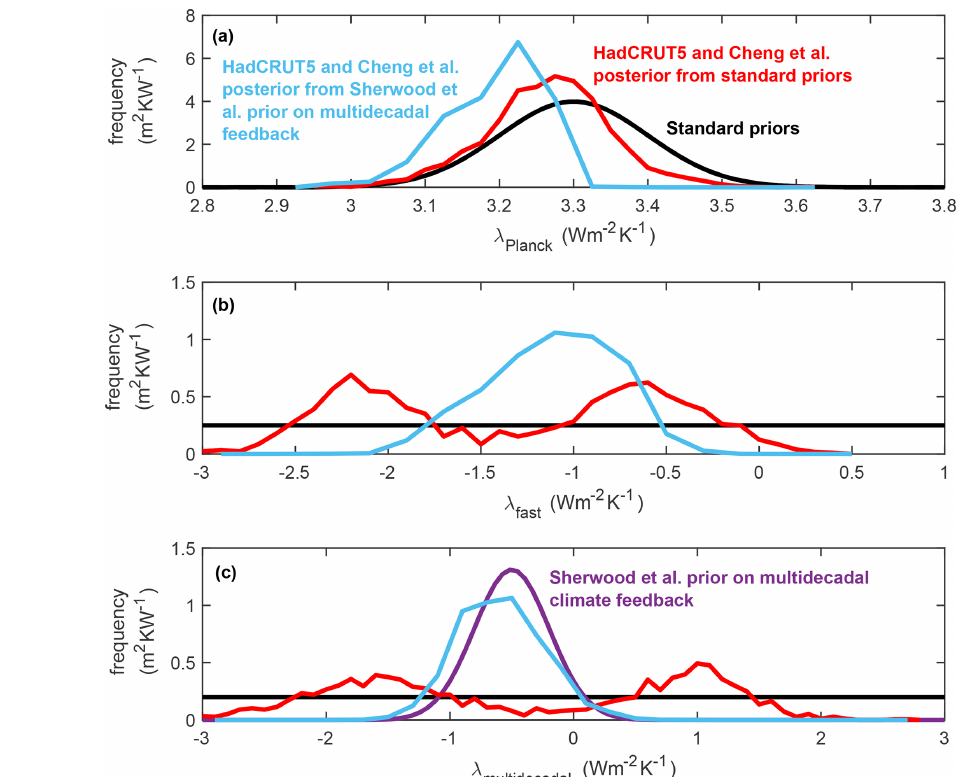
Figure 8. The prior and posterior distribution of climate feedback terms, showing the impact of alternative prior distribution for multi- decadal climate feedback. Black lines show the standard prior distributions (as Fig. 2a–c), while the purple line (c) shows the alternative prior distribution for multi-decadal feedback from Sherwood et al. (2020). Red lines show the posterior in the HadCRUT5 and Cheng et al. ensemble for the standard prior distributions (as Fig. 2a–c), and light blue lines show the posterior distributions for climate feedback terms when using the alternative multi-decadal